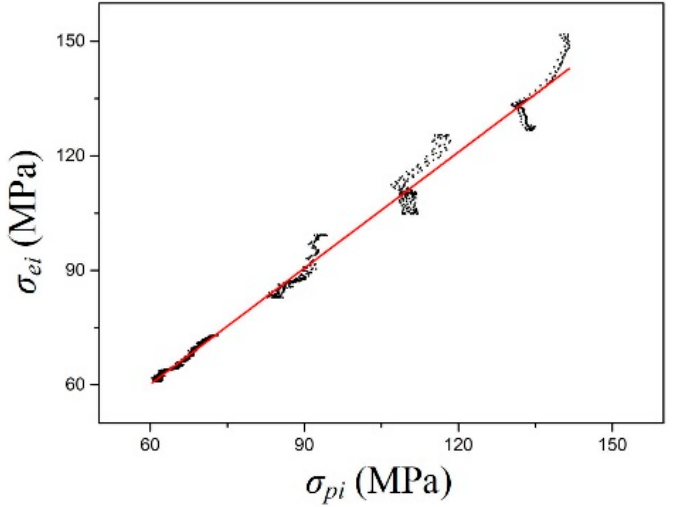
Figure 8. The correlation between the predicted flow stress value of the model fitted by a fourth- order polynomial and the experimental value.